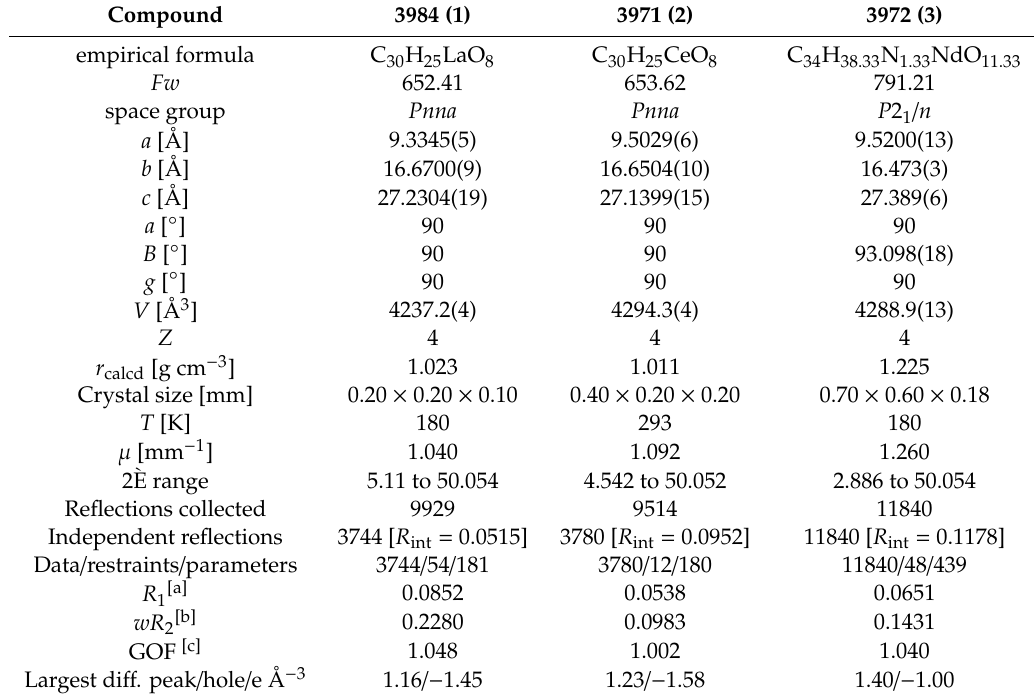
Table 3. Crystal data and details of the data collection for 1 – 3 .